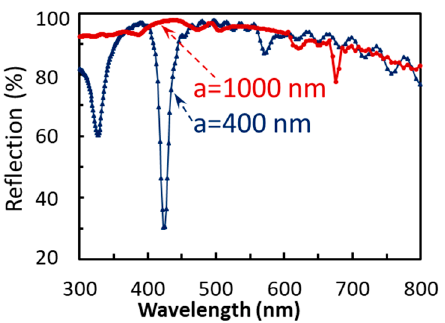
Figure 3. Simulated reflection as a function of wavelength from Al-coated GPSC with periods of 1000 and 400 nm.